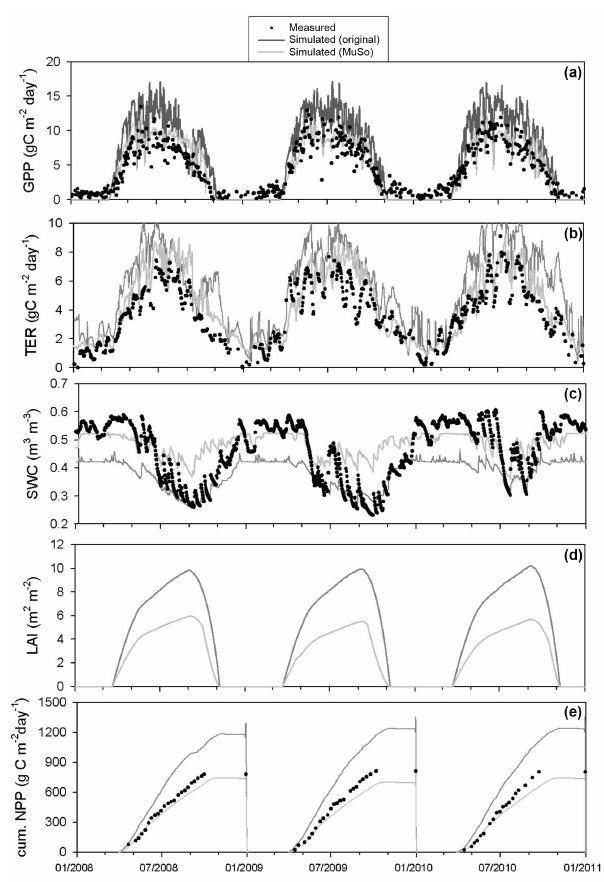
Figure 8. Measured (black dots) and simulated variables using orig- inal Biome-BGC (dark grey lines) and BBGCMuSo (light grey lines) regarding deciduous broad-leaved forest at the Jastrebarsko site between 2008 and 2010. (a) GPP, (b) TER, (c) SWC (note: original Biome-BGC provides simulation results only for one layer, namely “the rooting depth”, which is 0–100cm in this case), (d) LAI, (e) cumulative NPP. Note that measured LAI is not avail-